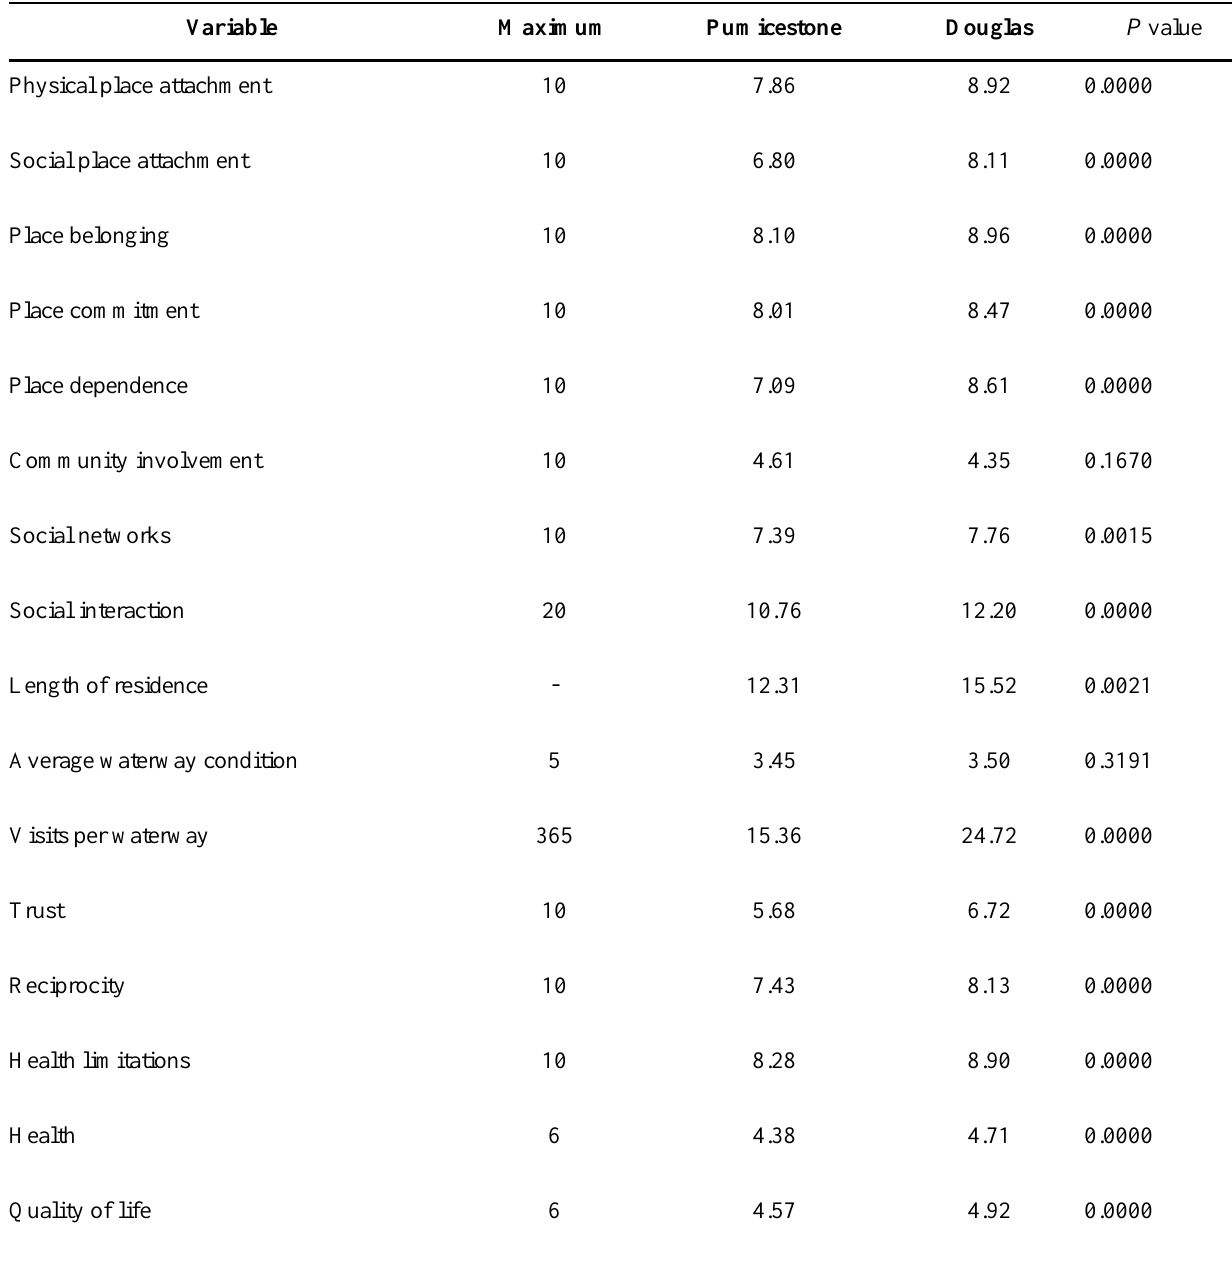
Table 3. Mean result for each variable in each region and P value for t -test of difference between the regions. Variable Maximum Pumicestone Douglas P